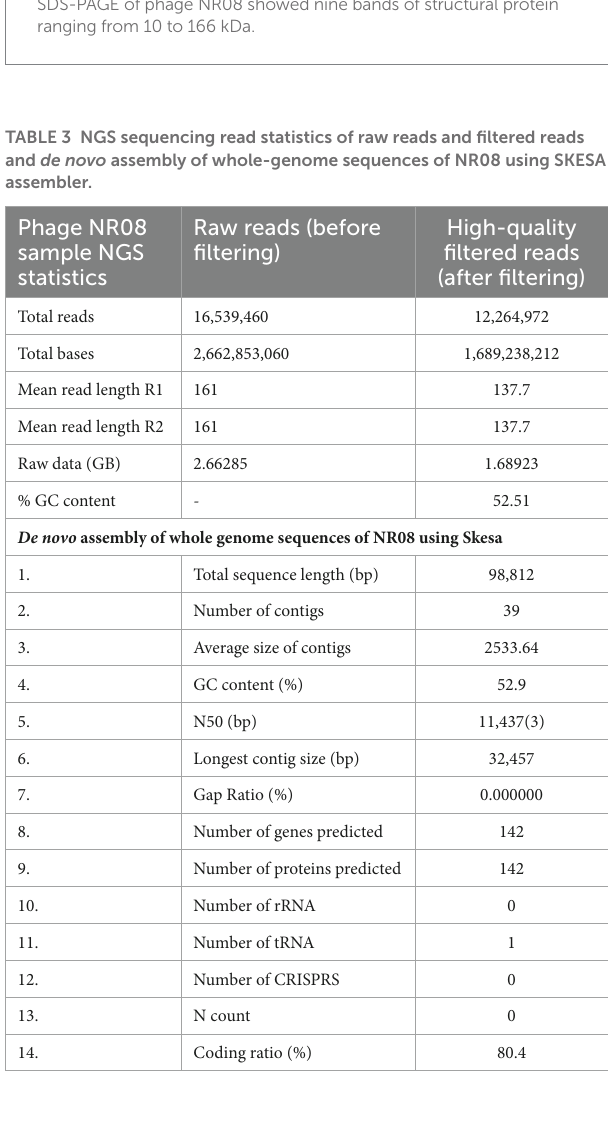
FIGURE 5 Protein profiling of phage NR08 using SDS-PAGE run along with broad range protein molecular weight markers M (Promega). The SDS-PAGE of phage NR08 showed nine bands of structural protein ranging from 10 to 166